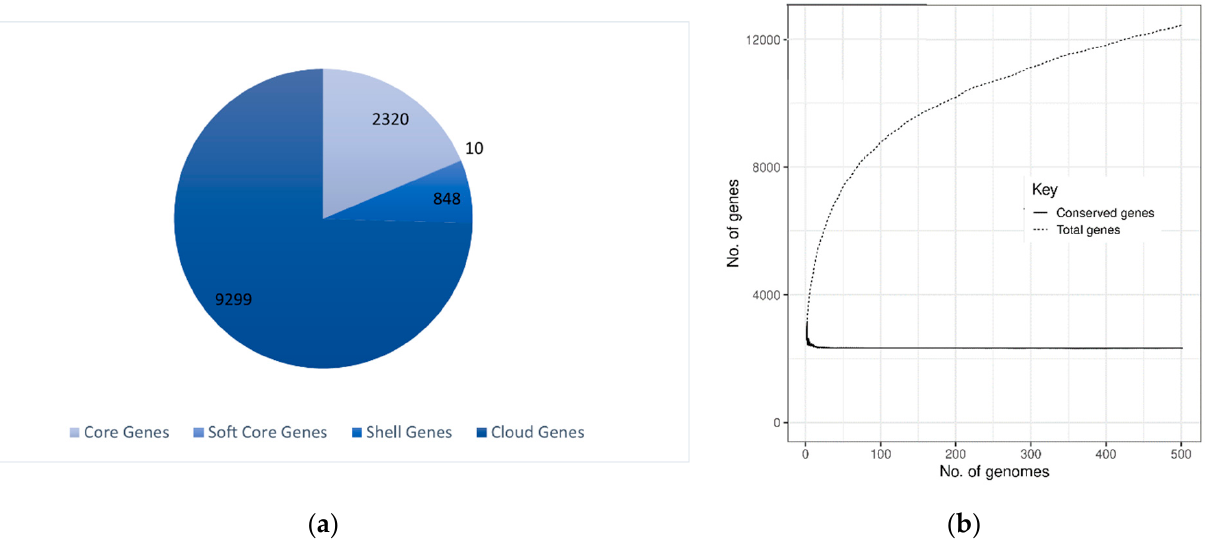
Figure 4. The Pangenome analysis of S. aureus : ( a ) Pie chart depicts the core genes, soft core genes, shell genes, and cloud genes. ( b ) The pan vs. core genome plot of 502 strains where the core genome size drops initially and becomes constant afterward; however, the pangenome continues to increase in